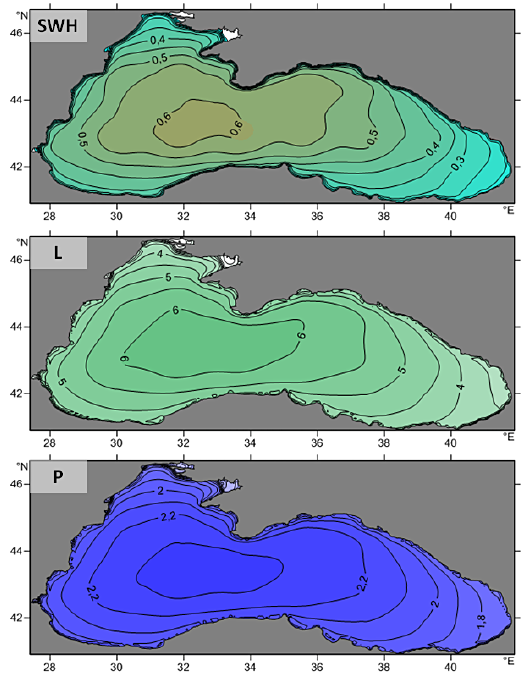
Figure 8. Maps of calculated average significant wave height [m], wave length [m] and period [s] in